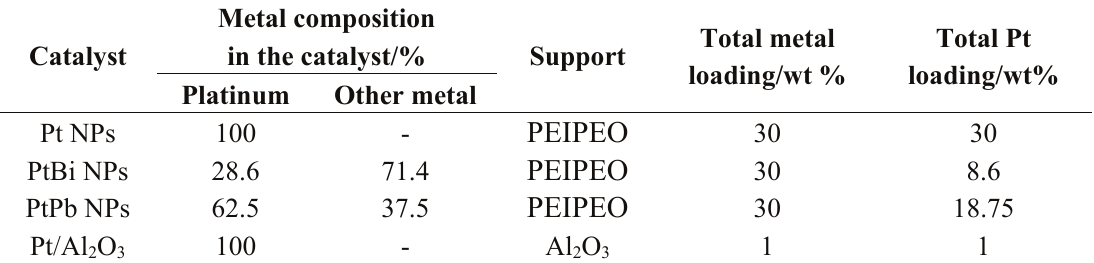
Table 5. Composition of the mono- and bi-metallic platinum-based